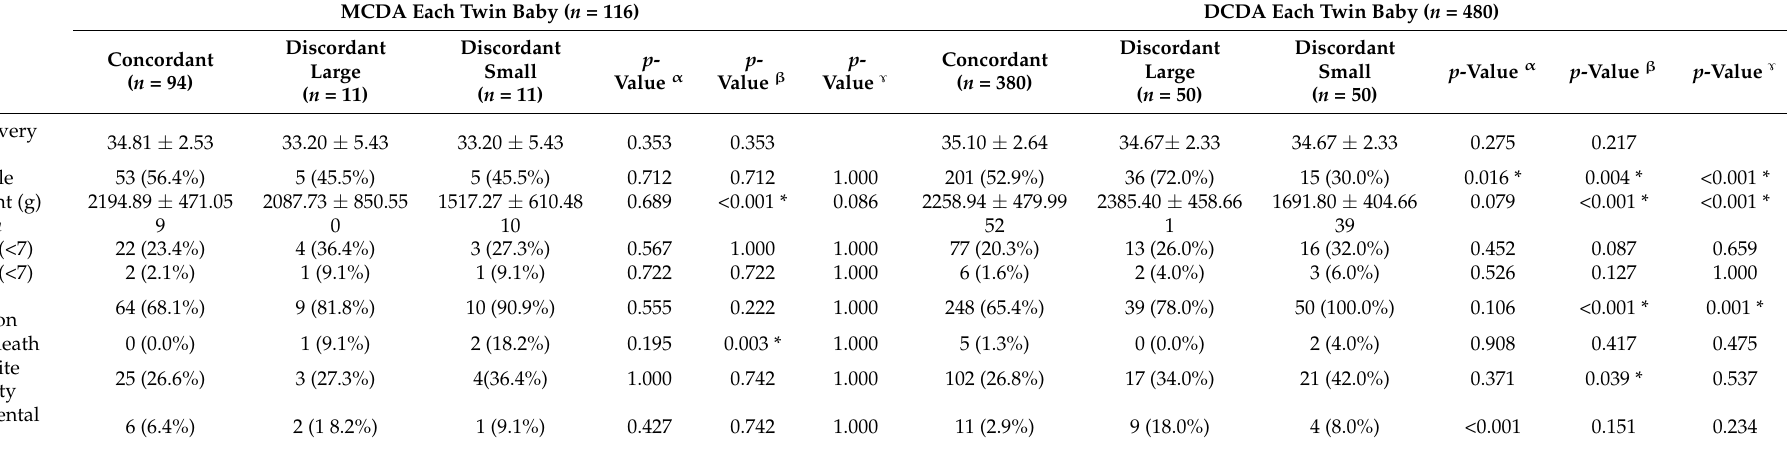
Table 3. Comparison of neonatal outcomes of concordant twins with discordant larger and smaller neonates according to chorionicity.